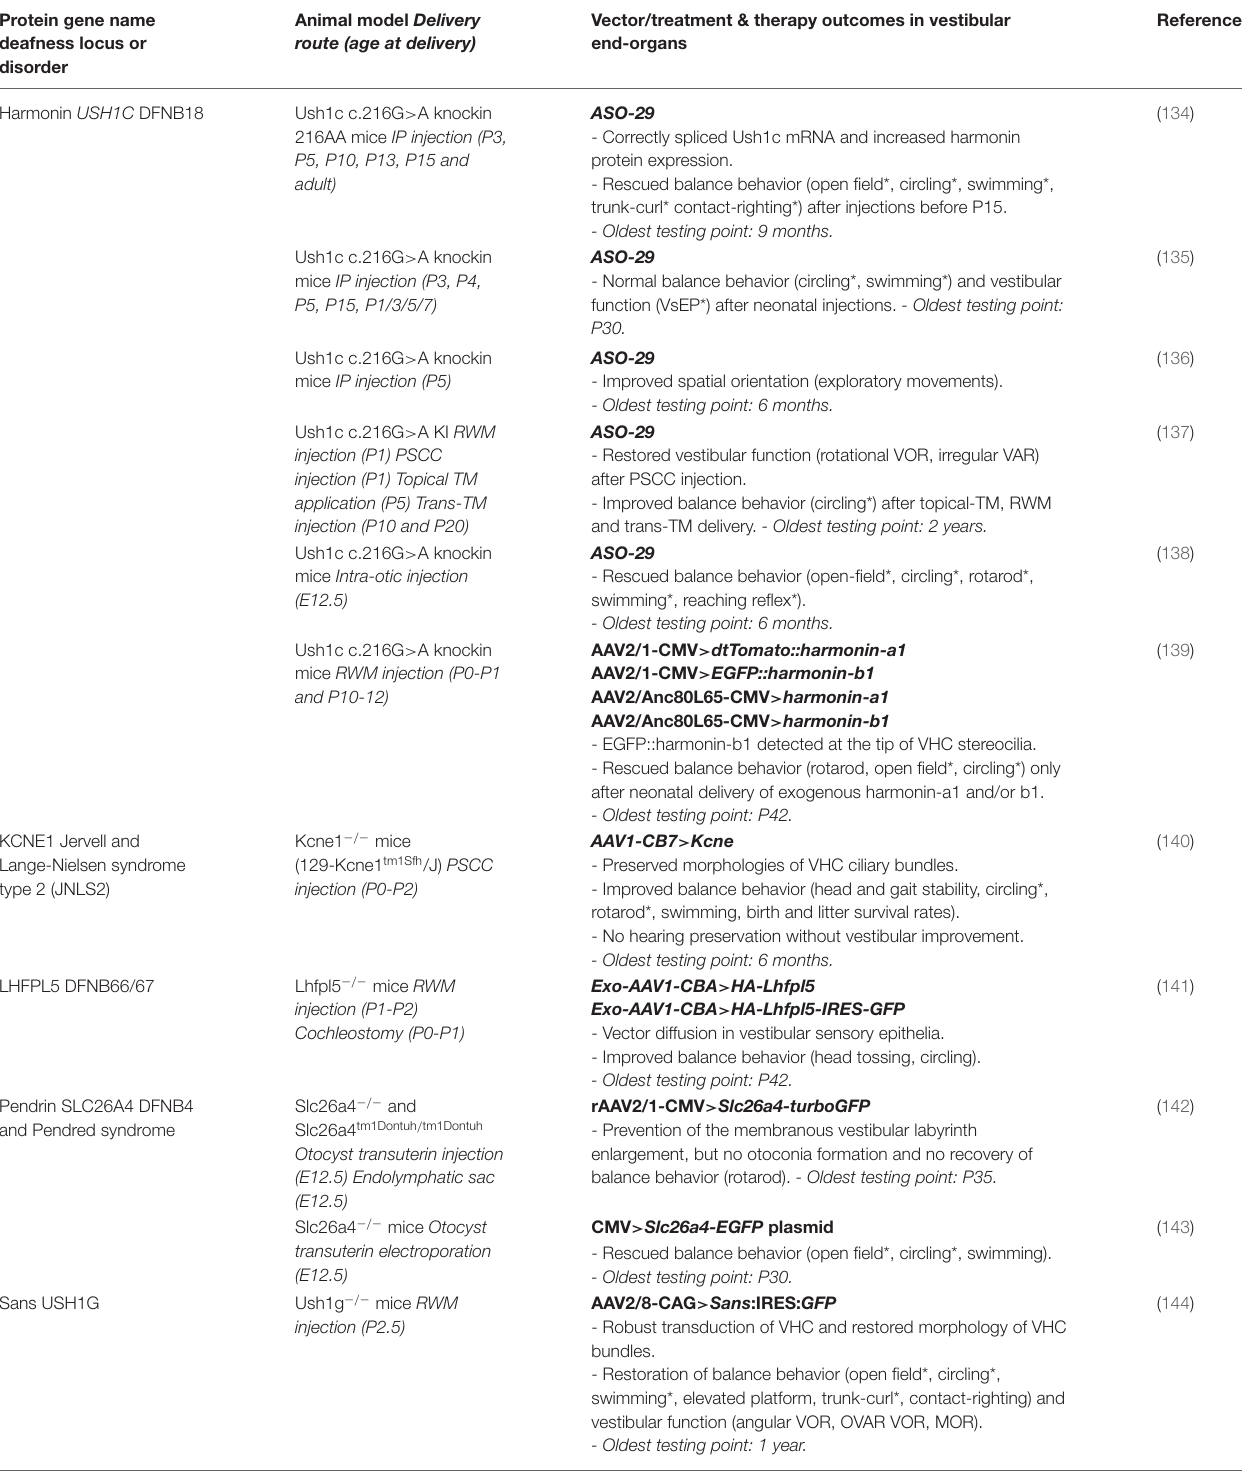
TABLE 1 | Gene therapies in animal models with vestibular deficits. Protein gene name deafness locus